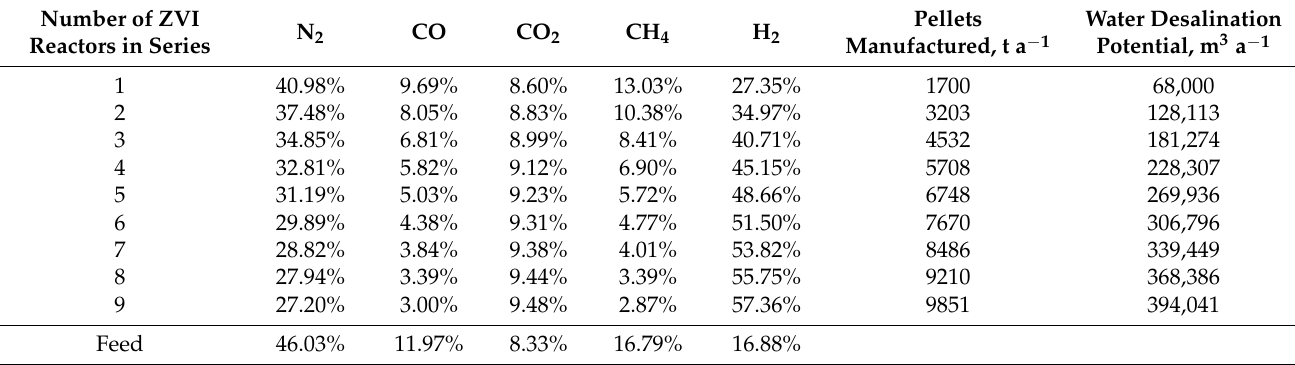
Table 3. Expected Product Gas Composition, pellets manufactured and desalination water potential of the manufactured pellets. Assumptions: ZVI Reactors are placed in series where the product gas from one reactor is passed directly into the next downstream reactor. Manufactured volumes are based on a feed gas flow rate of 14 m 3 m − 1 . The product gas volume from 9 reactors placed in series is 23.69 m 3 m − 1